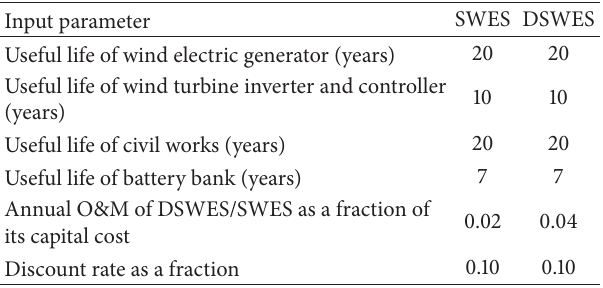
Table 3: Estimated annual energy output and corresponding LUCE of the DSWES and the